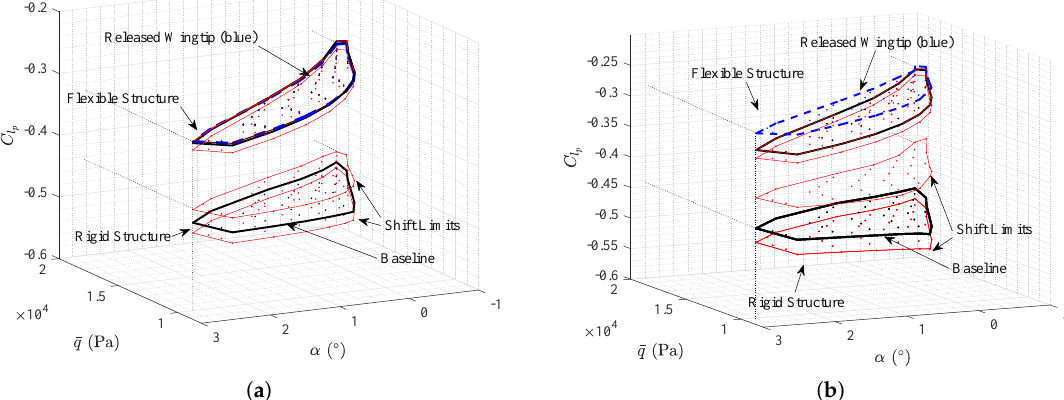
Figure 10. C l variations against ¯ q and α b : ( a ) 2.9 m (10% wing semispan) wingtip device; and ( b ) 5.8 m p (20% wing semispan) wingtip device.